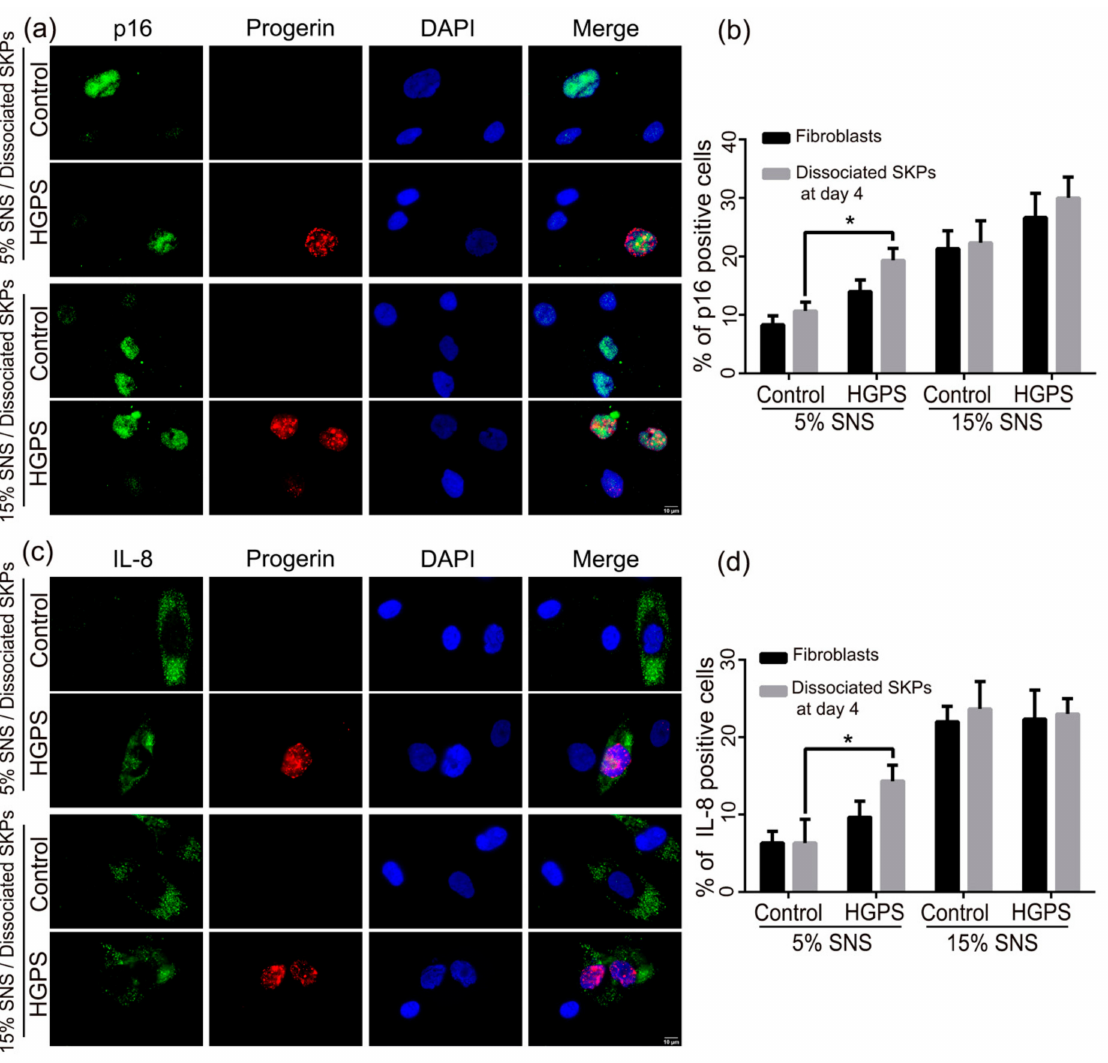
Figure 4. Immunofluorescence staining for p16 and IL-8 in dissociated control and HGPS SKPs at day 4. ( a ) Immunoflu- orescence staining for p16 and progerin at day 4 in dissociated spheroids from control and HGPS SKPs with 5 and 15% SNS. ( b ) Quantification of the percentage of p16-positive nuclei in the initial fibroblast cultures and in dissociated SKPs at day 4 from both control and HGPS cultures. ( c ) Immunofluorescence staining for IL-8 and progerin at day 4 in dissociated spheroids from control and HGPS SKPs with 5 and 15% SNS. Cells were counterstained with DAPI. ( d ) Quantification of the percentage of IL-8-positive cells at day 4 in the initial fibroblast cultures and in dissociated SKPs from both control and HGPS cultures. Values are presented as mean ± SD ( n = 3), * p < 0.05, ( c ) two-way ANOVA with Tukey’s multiple comparisons